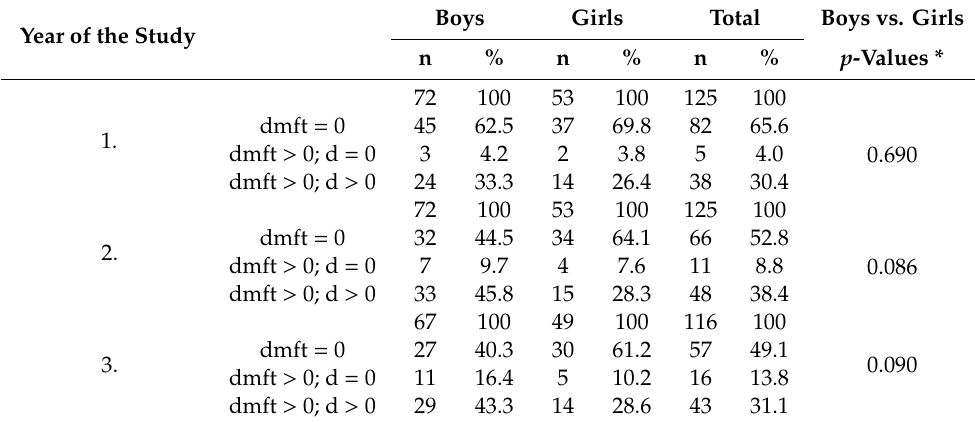
Table 2. Examination of the deciduous teeth.